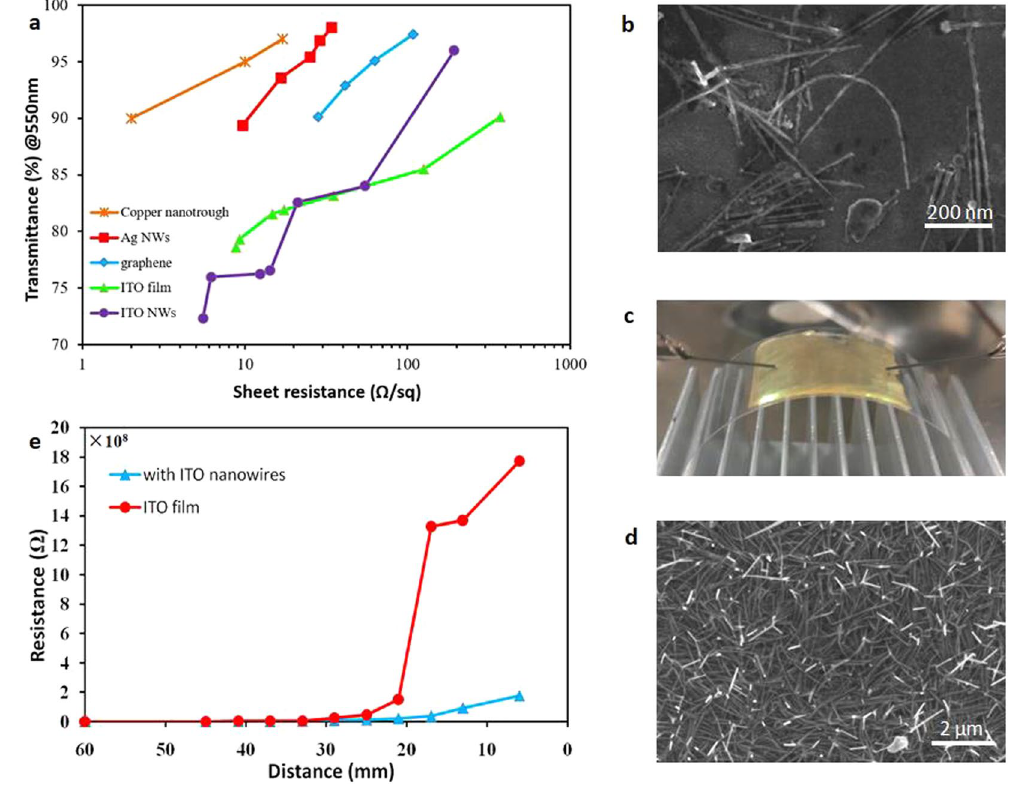
Figure 7. ITO nanowire networks as transparent and flexible electrode. ( a ) Sheet resistance versus optical transmission (@550 nm) for coppernanotrough 19 , silver nanowires (Ag NWs) 17 , grapheme 7 , ITO film and ITO nanowire networks. ( b ) The ITO nanowires have strong flexibility. Samples with ITO nanowires were placed in the acetone solution, shaken by sonication for 0.5 h, and then precipitated. A suspension containing ITO nanowires was obtained by removing the supernatant diluted solution. The ITO nanowire suspension was coated on silicon. ( c ) An electrical conductivity test under bending. ( d ) SEM images of the 3D ITO nanowires after being squeezed by a PET template. ( e ) Resistance versus bending radius for bendable transparent electrodes consisting of ITO nanowire networks or ITO films on 200- μ m-thick PET